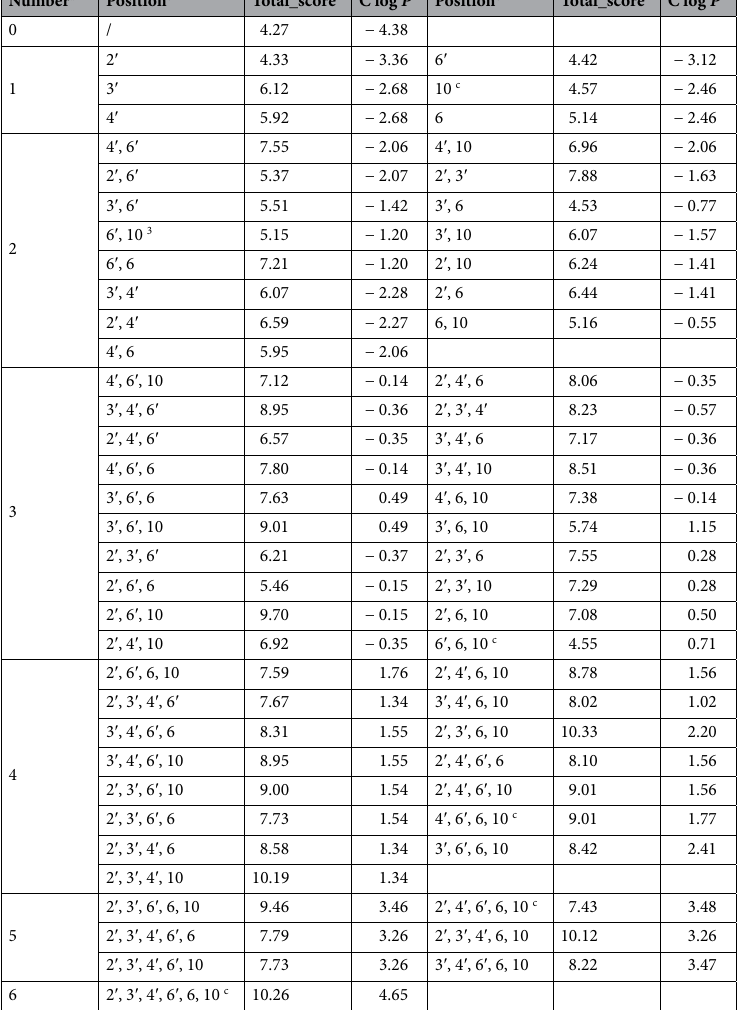
Table 1. Total_score of CCs docked with GSH-Px and their C log P. a Number of crotonylated hydroxyl groups in CCs. b Positions of crotonylated hydroxyl groups in CCs. c The isomer with minimum molecular energy in